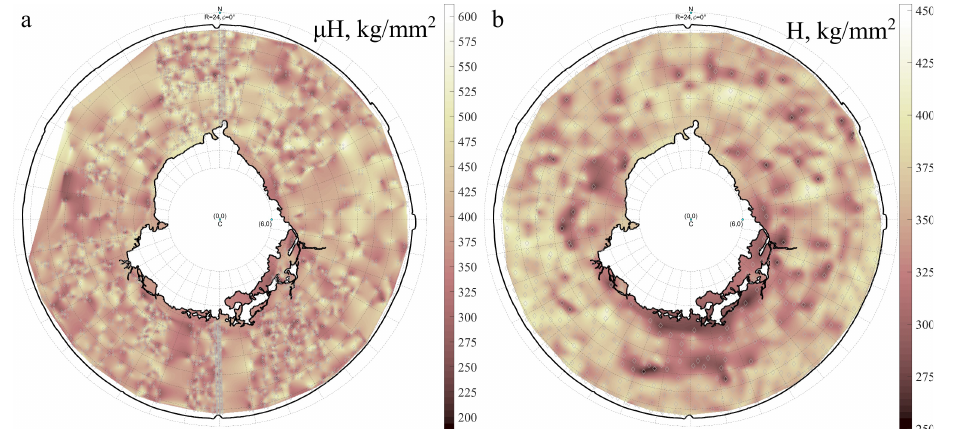
Fig. 5. Color maps of microhardness (a) and hardness (b) distribution over the meridional cross-section of the